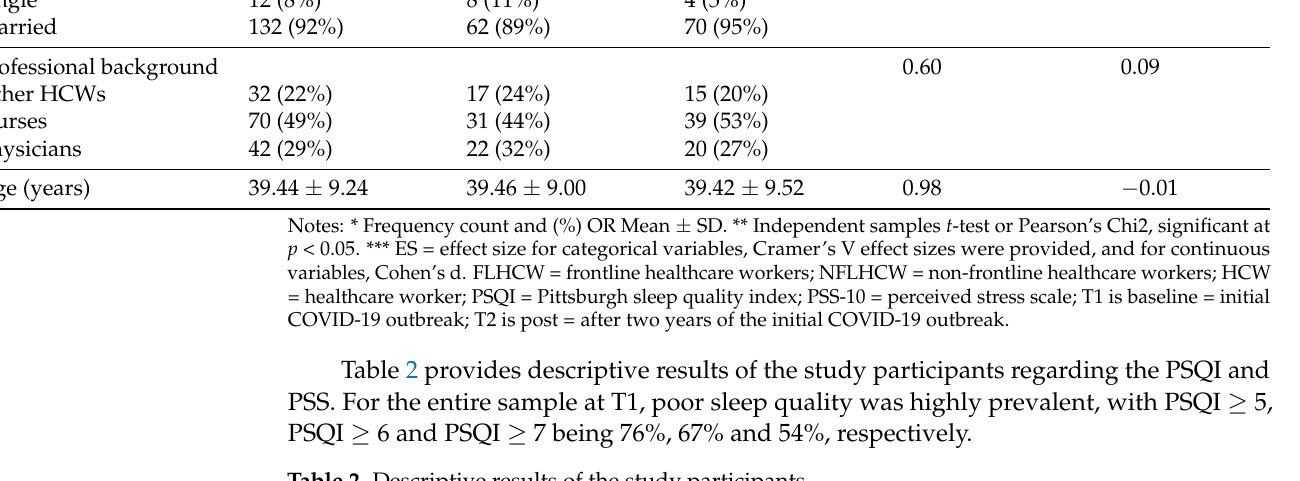
Table 2. Descriptive results of the study